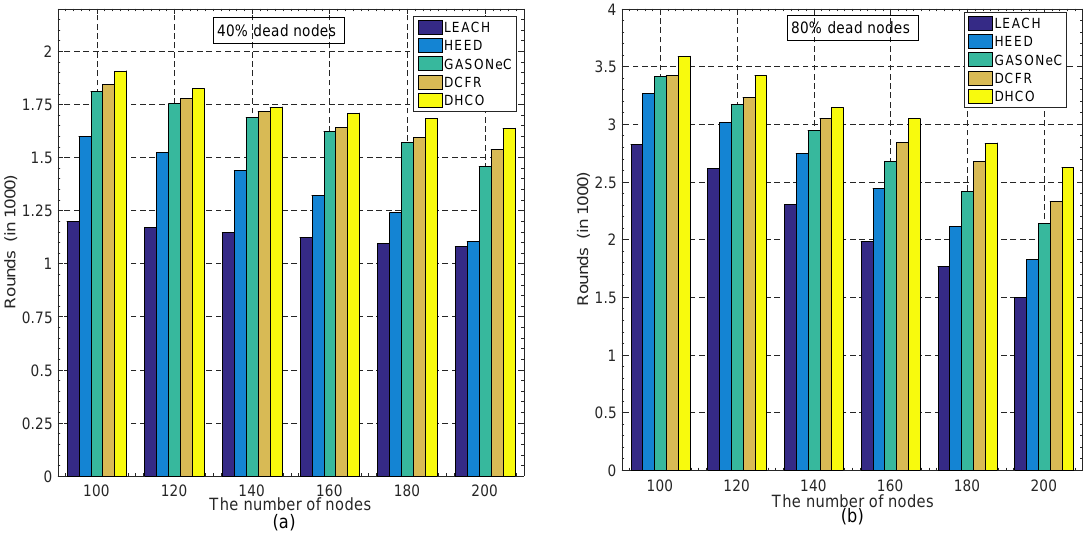
Figure 6. Comparison of transmission rounds with different dead sensor nodes for various algorithms in the deployment scenarios of the 100 m × 100 m square region and the coordinate (50, 50) of the BS: ( a ) at the 40% dead-sensor-nodes level for different numbers of sensor nodes, and ( b ) at the 80% dead-sensor-nodes level for different numbers of sensor